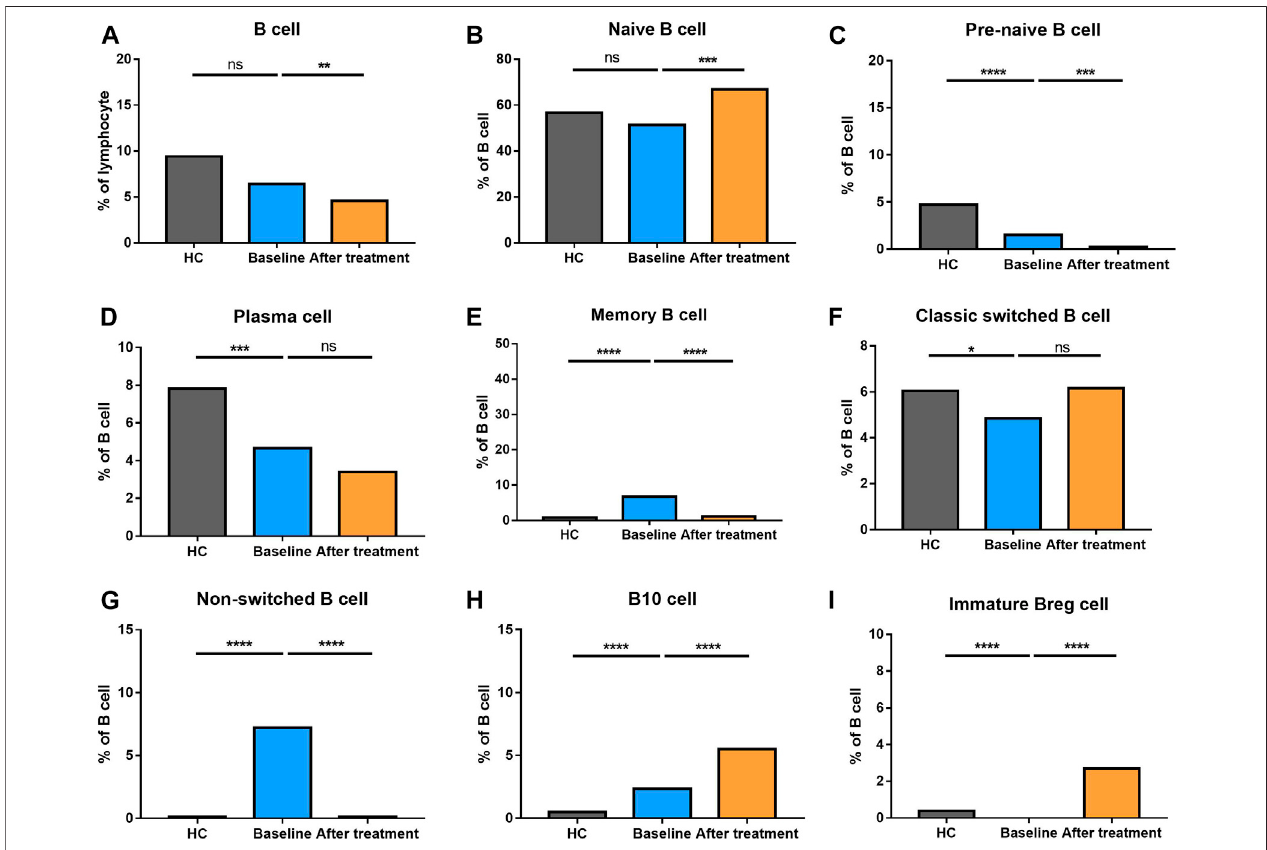
FIGURE 6 | Altered expression of B cell subsets in AS patients after treated with secukinumab. The proportion of B cell subsets measured by fl ow cytometry at baseline and after receiving secukinumab in AS patients. Breg, regulatory B cell. ns, not signi fi cant; *, p < 0.05; **, p < 0.01; ***, p ≤ 0.001; ****, p < 0.0001.